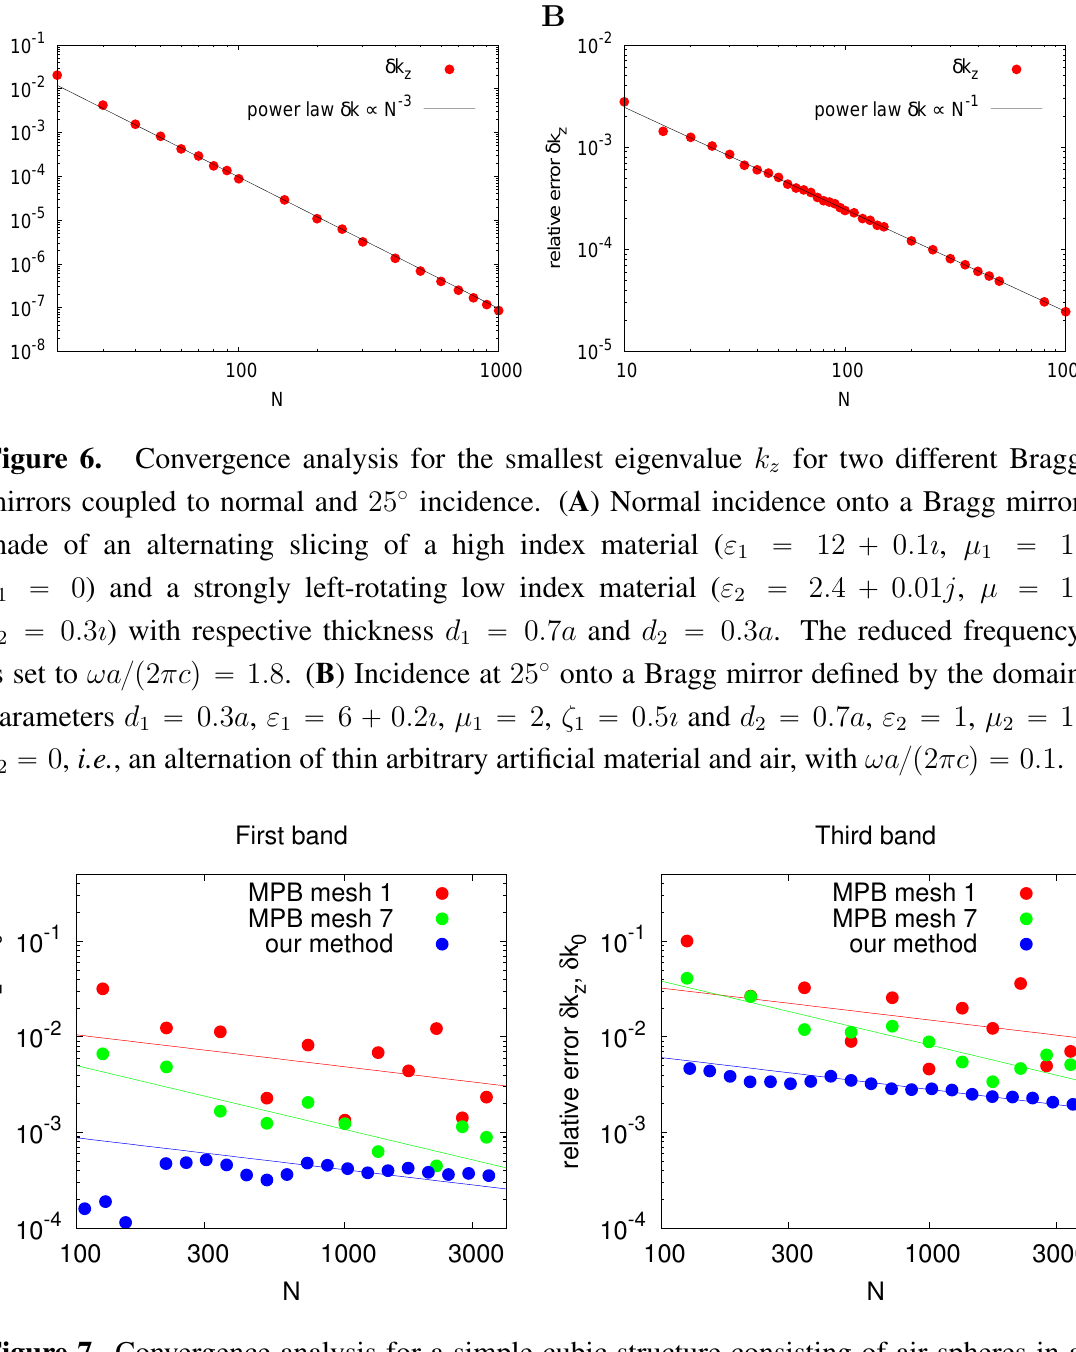
Figure 7. Convergence analysis for a simple cubic structure consisting of air spheres in a silicon matrix ( ε “ 12 ). The points represent the relative error of MPB and our method (with respect to a converged MPB solution k p N q p k “ 0 . 2 q with N “ 128 3 and a mesh z 0 size of seven) for different numbers of plane waves up to N « 4000 , above which memory requirements become unfeasible on most machines. The spatial structure is represented by a triangulated sphere with 384 triangles generated with Ken Brakke’s surface evolver [43] for our method and generated with the internal geometry class sphere in the case of MPB. , δk Straight lines represent power law fits δk 9 N ´ 1 { 3 for our method and MPB without z 0 ε -averaging (mesh 1 ) and δk 9 N ´ 2 { 3 with averaging (on a mesh of 7 3 sub-pixels) 0